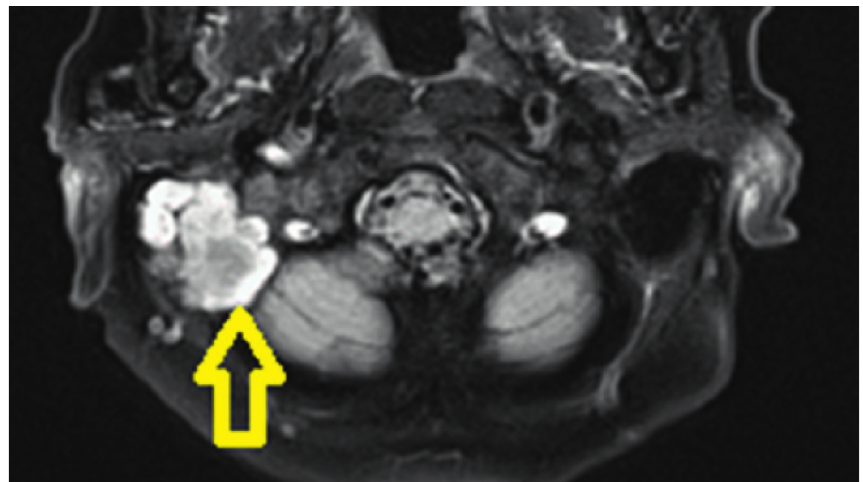
Figure 2: Initial T2-weighted magnetic resonance imaging revealing a mass occupying the right middle ear and mastoid (yellow